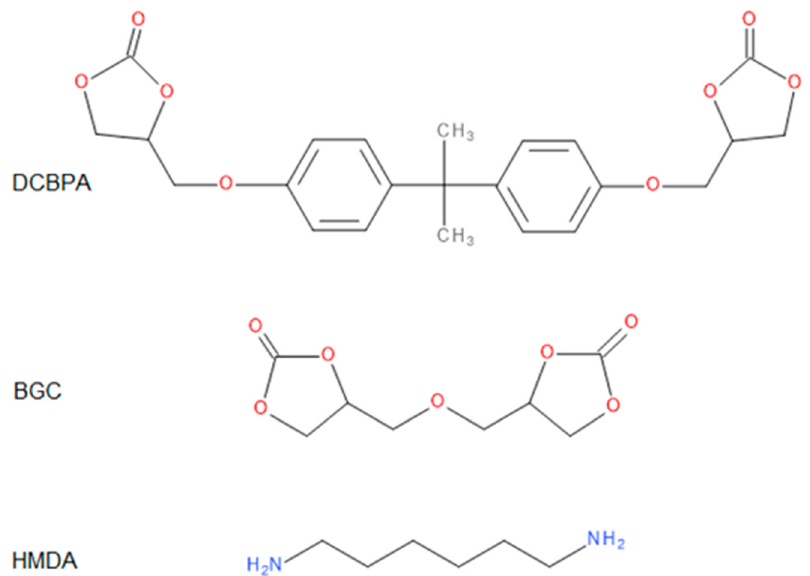
Figure 2. Structures of the reagents.